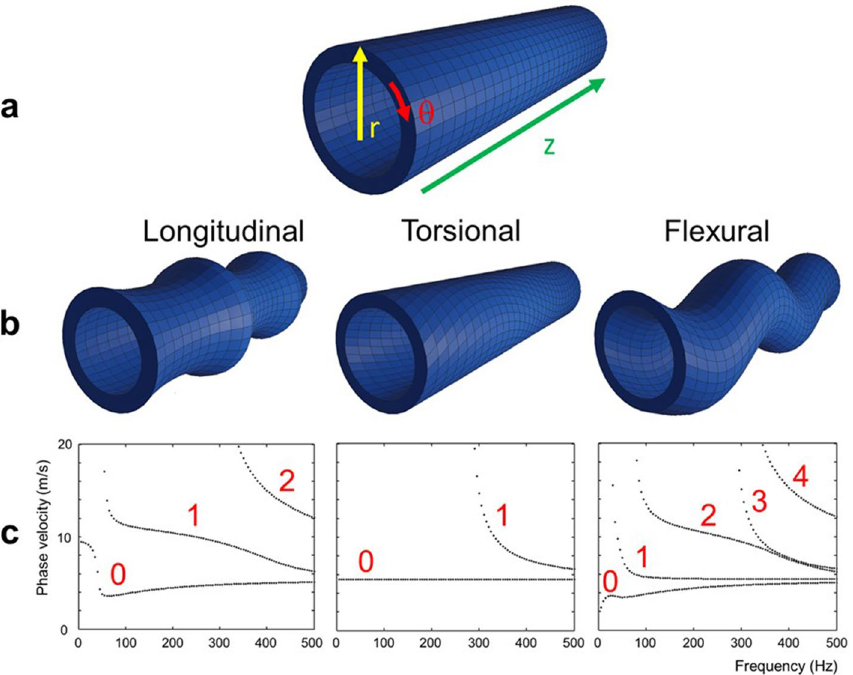
Figure 1. Different wave modes in a hollow cylindrical structure. (a) Geometrical displacement directions of a wave in a cylinder. The green arrow describes the axial displacement in the z -direction; the yellow arrow radial displacement; and the red arrow circumferential displacement. ( b) Visualization of displacement behavior for longitudinal, torsional, and flexural modes in a hollow cylinder, respectively. ( c) The phase velocities of the 3 fundamental modes (left to right: longitudinal, torsional, flexural) and their higher order modes in the bandwidth from 0 to 500 Hz for a cylinder of 30 mm inner radius, 10 mm wall thickness, shear velocity √30 m/s, longitudinal velocity 1550 m/s, density 1000 kg/m 3 . The lowest order torsional mode is non-dispersive and hence propagates at a speed reflecting the true material properties independent of the frequency and the